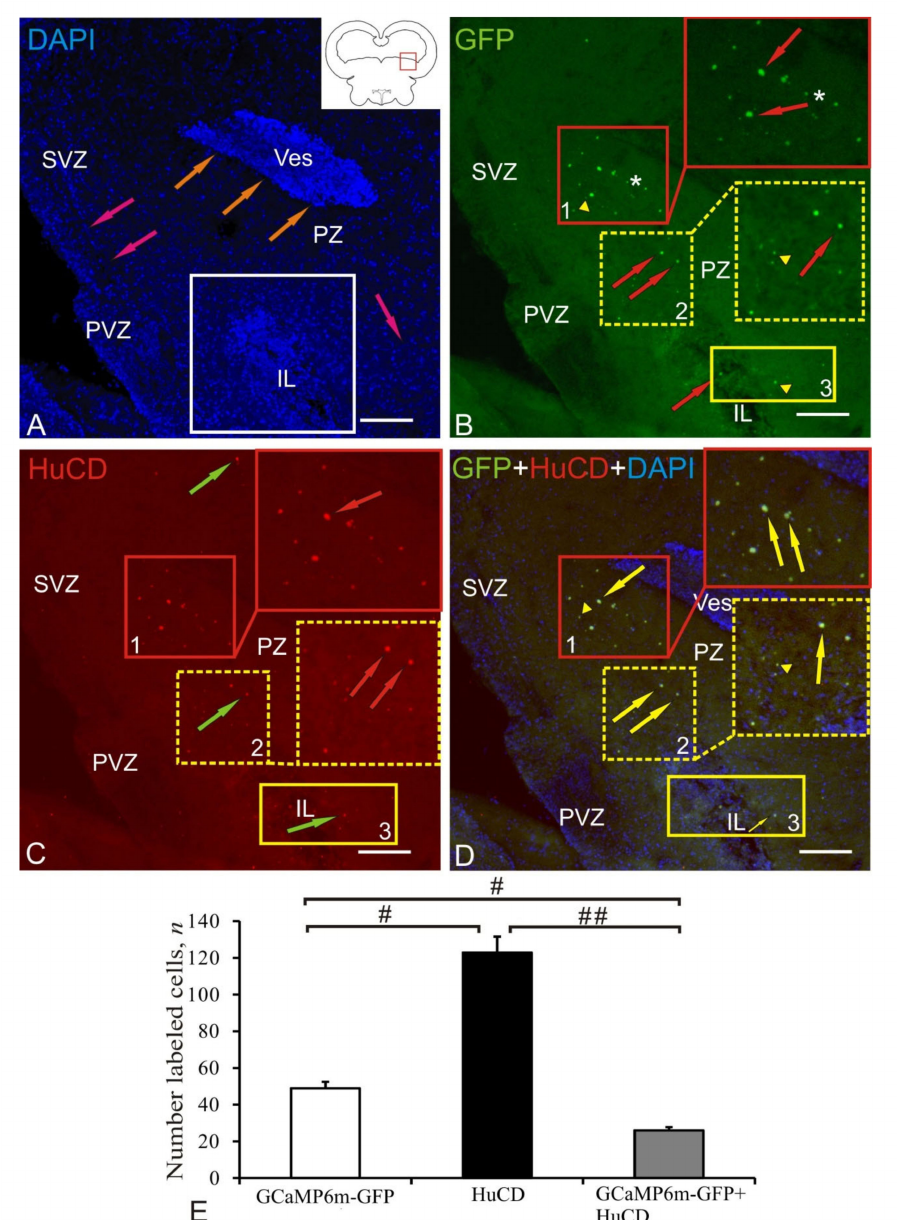
Figure 6. Z-stacks representing HuCD immunolabeling in the dorso-lateral tegmentum of juvenile chum salmon, O. keta , at 1 week after a single injection of recombinant AAV into the mesencephalic tegmentum area. ( A ) DAPI staining, the pictogram shows the area of the dorso-lateral tegmentum (outlined by red rectangle), pink arrows indicate nuclei, orange arrows indicate the dilated blood sinus (Ves), the post-injection cavity (IL) is outlined by the white square. ( B ) Expression of GFP in cell populations: outlined by the red rectangle (population № 1, an enlarged fragment in the inset), single GFP+ cells (red arrows), GFP+ nuclei (white asterisk), GFP+ granules (yellow arrowhead), population № 2, on inset enlarged fragment (in the yellow dotted rectangle), population № 3 (in the yellow rectangle). ( C ) Immunofluorescence of HuCD in populations № 1–3 of neurons (green arrows, red arrows in the inset, other designations as in ( B )). ( D ) Superposition of three DAPI/GFP HuCD staining channels, showing areas of GFP/HuCD colocalization in neurons (yellow arrows). Laser scanning confocal microscopy. Scale bar: 200 µ m. ( E ) Results of ANOVA analysis showing the comparative distribution of labeled cells and nuclei (M ± SD, where M is the mean and SD is the standard deviation) of the dorso-medial tegmentum of chum salmon. Significant intergroup differences were found between the groups of GCaMP6m-GFP+ and HuCD+ cells, the GCaMP6m- GFP+ and GCaMP6m-GFP+/HuCD+ cells (# < 0.05), and between the groups of HuCD+ and GCaMP6m-GFP+/HuCD+ (## < 0.01) cells ( n = 5 in each